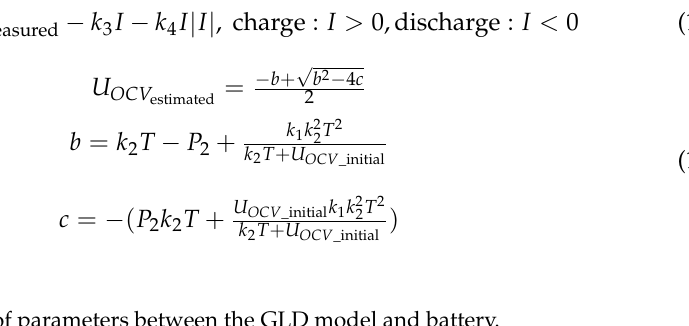
Table 1. Correspondence of parameters between the GLD model and